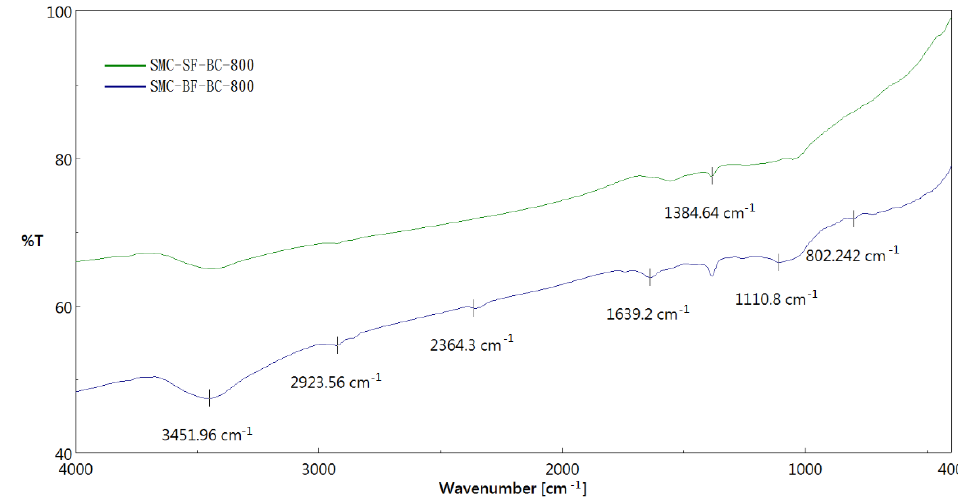
Figure 8. FTIR spectra of the biochar products (BC-SMC-SF-800 and BC-SMC-BF-800).